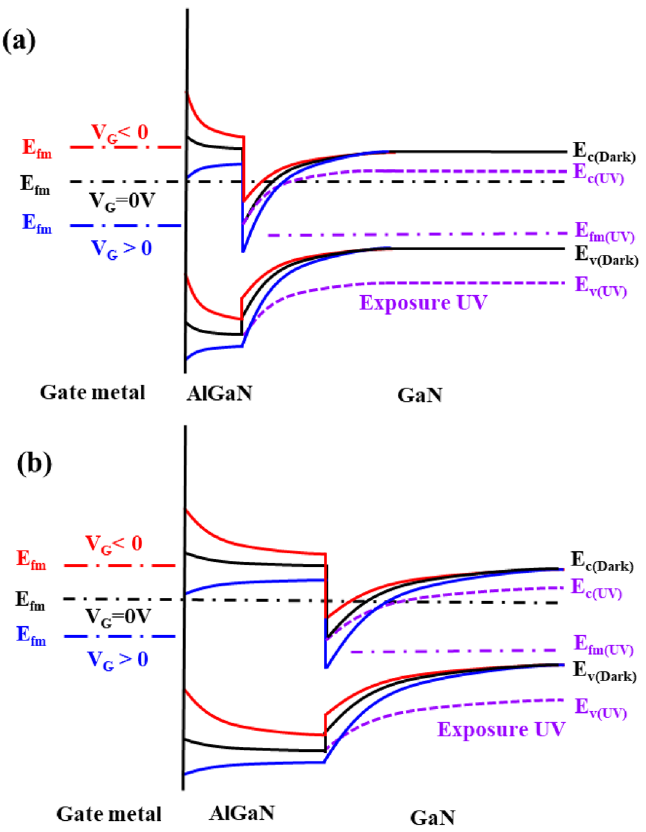
Figure 6. Schematic band diagrams of AlGaN/GaN HEMTs with 10 nm ( a ) and 30 nm ( b ) thick AlGaN barriers by applying zero (black line), positive (blue line), and negative (red line) gate biases. The solid and dotted lines depict bands with dark and UV illuminations,